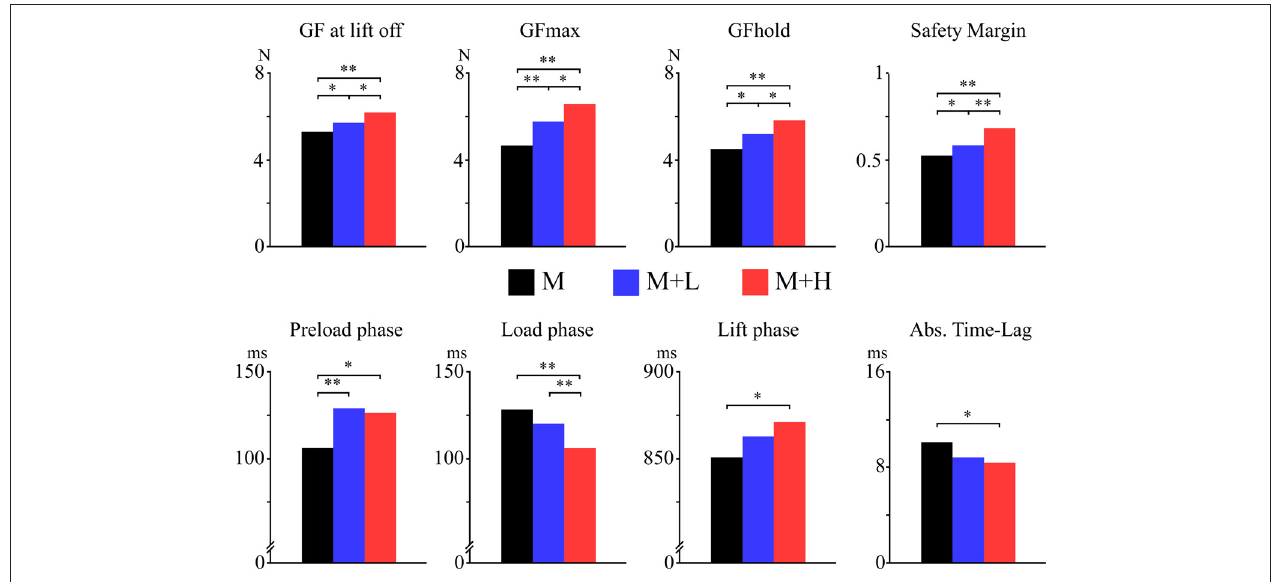
FIGURE 4 | Pairwise comparisons of the different measures of motor performance in the M (black bars), M + L (blue bars) and M + H (red bars) conditions. A single asterisk indicates a p -value < 0.05, double asterisks indicate a p -value < 0.001.